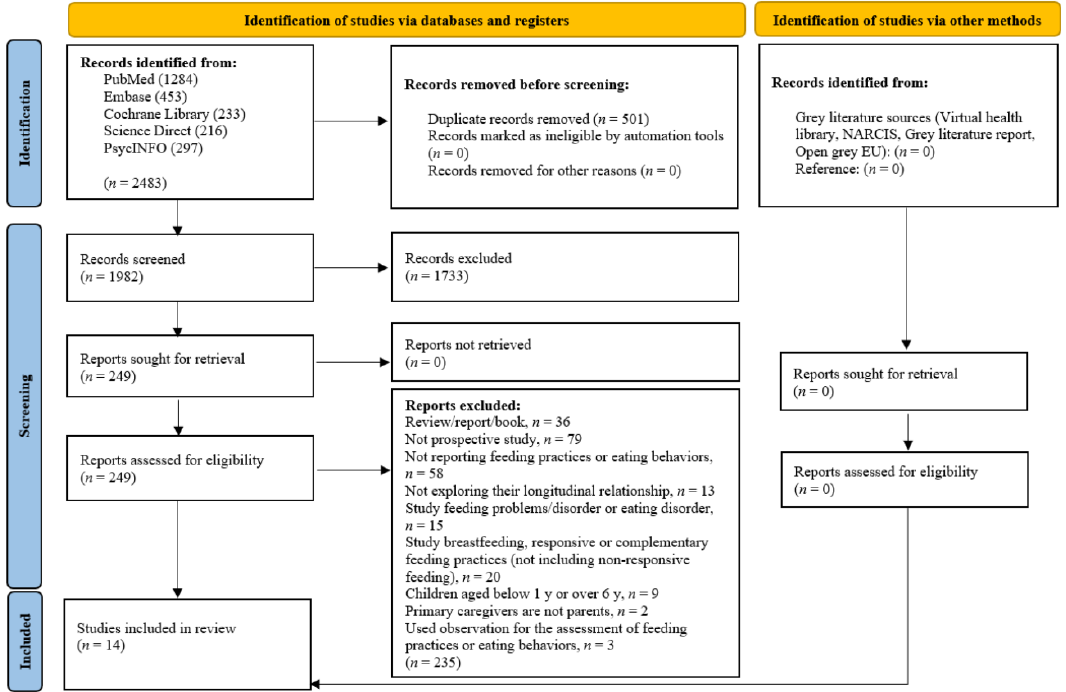
Figure 1. PRISMA flow diagram for screening and selection of